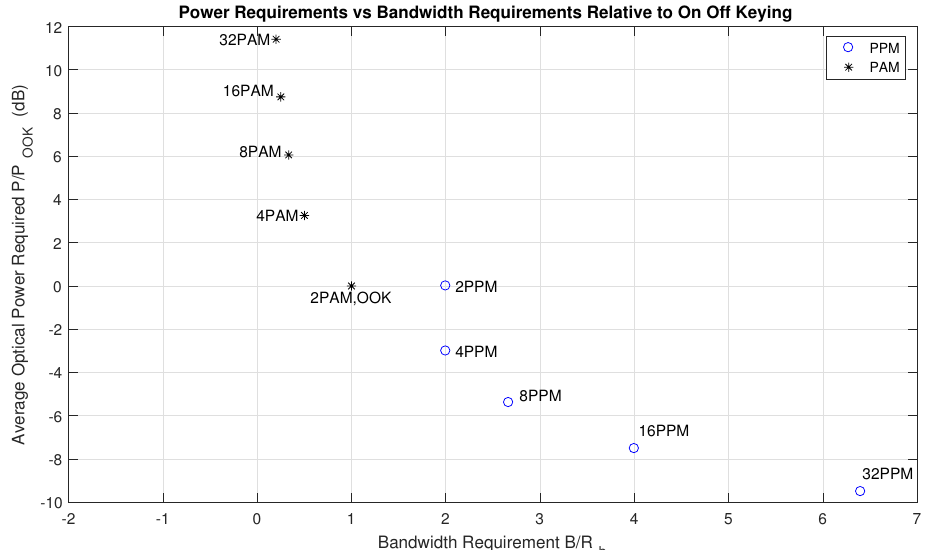
Figure 4. Pulsed Modulations Illustrating Power and Bandwidth Tradeoffs for L-PPM and M-PAM relative to OOK